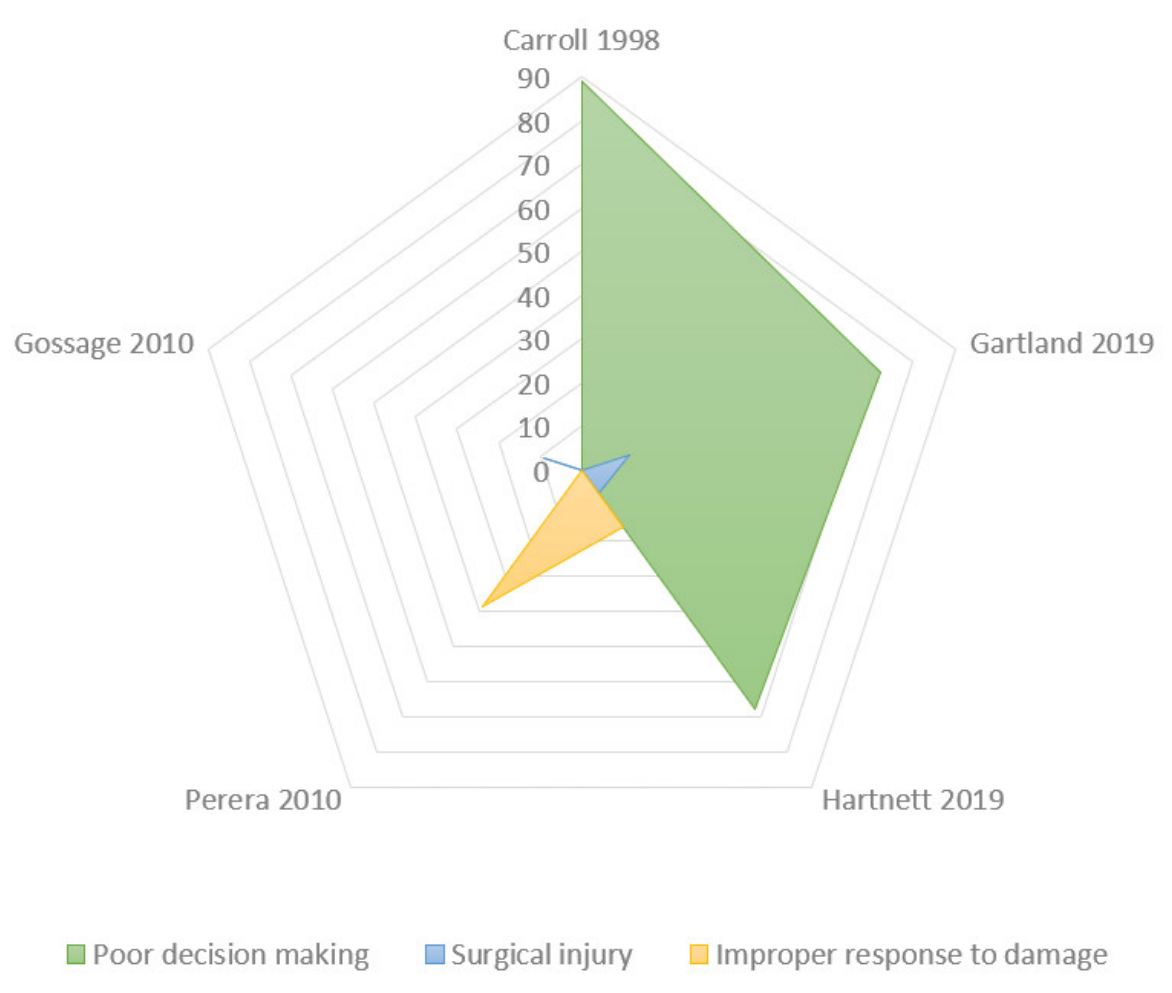
Figure 6. Radar chart: Causes of improper intraoperative surgical performance. The Radar chart shows the biggest polygon (green area) which is the most common indicator of intraoperative surgical performance: poor decision making or misinterpretation (“problematic visualization”). The areas of the smaller polygons (yellow: improper response to damage; blue: surgical injuries) are particularly small to demonstrate the few cases reported.